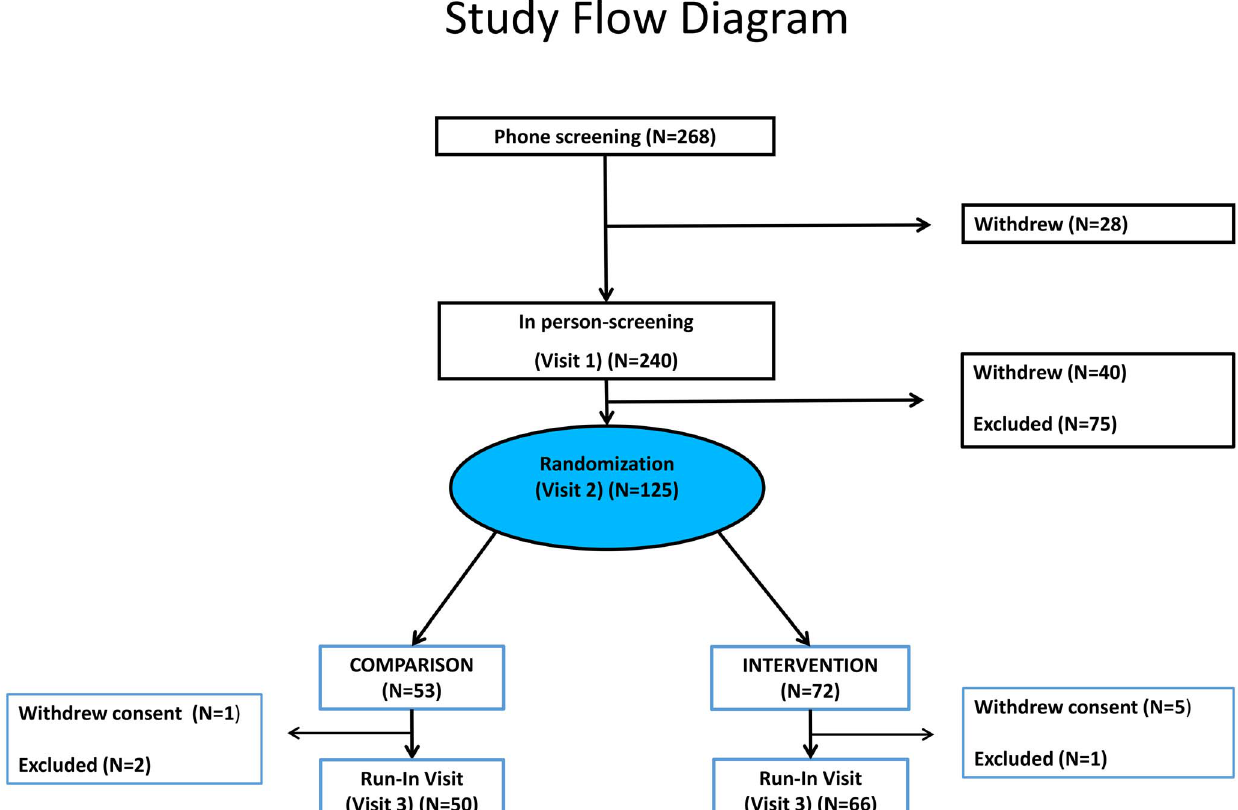
Figure 1. Study flow diagram.